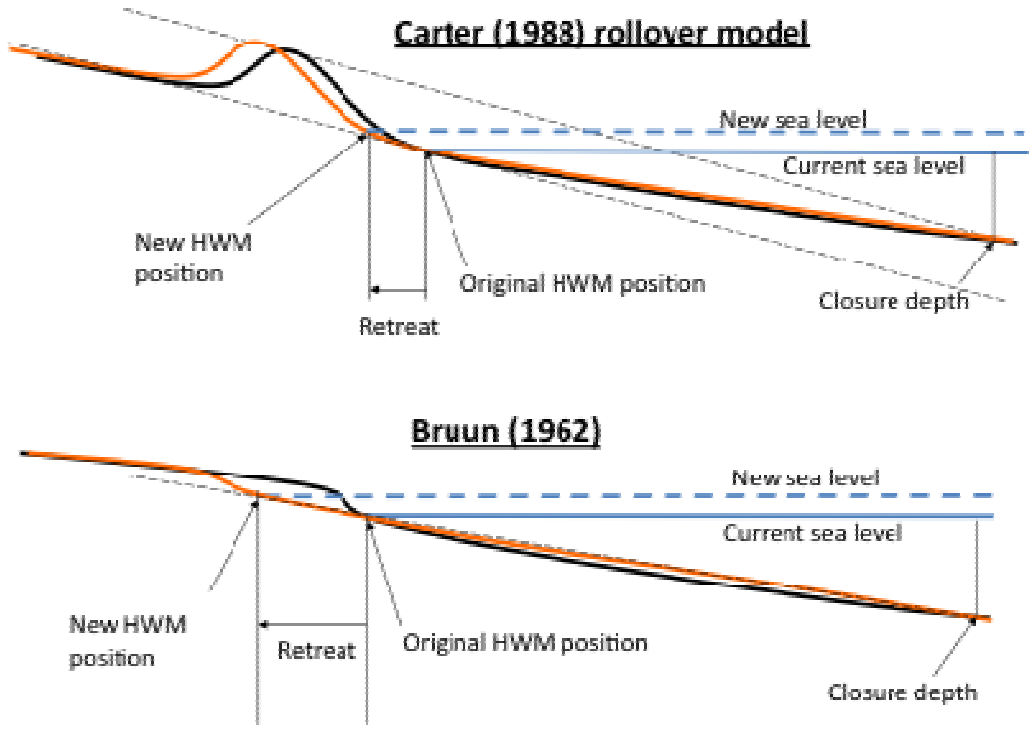
Figure 4. Cross-shore sections showing the application of the Carter [60] and Bruun [61] models. Original shoreline in solid black and sea level rise (SLR) modified shoreline in